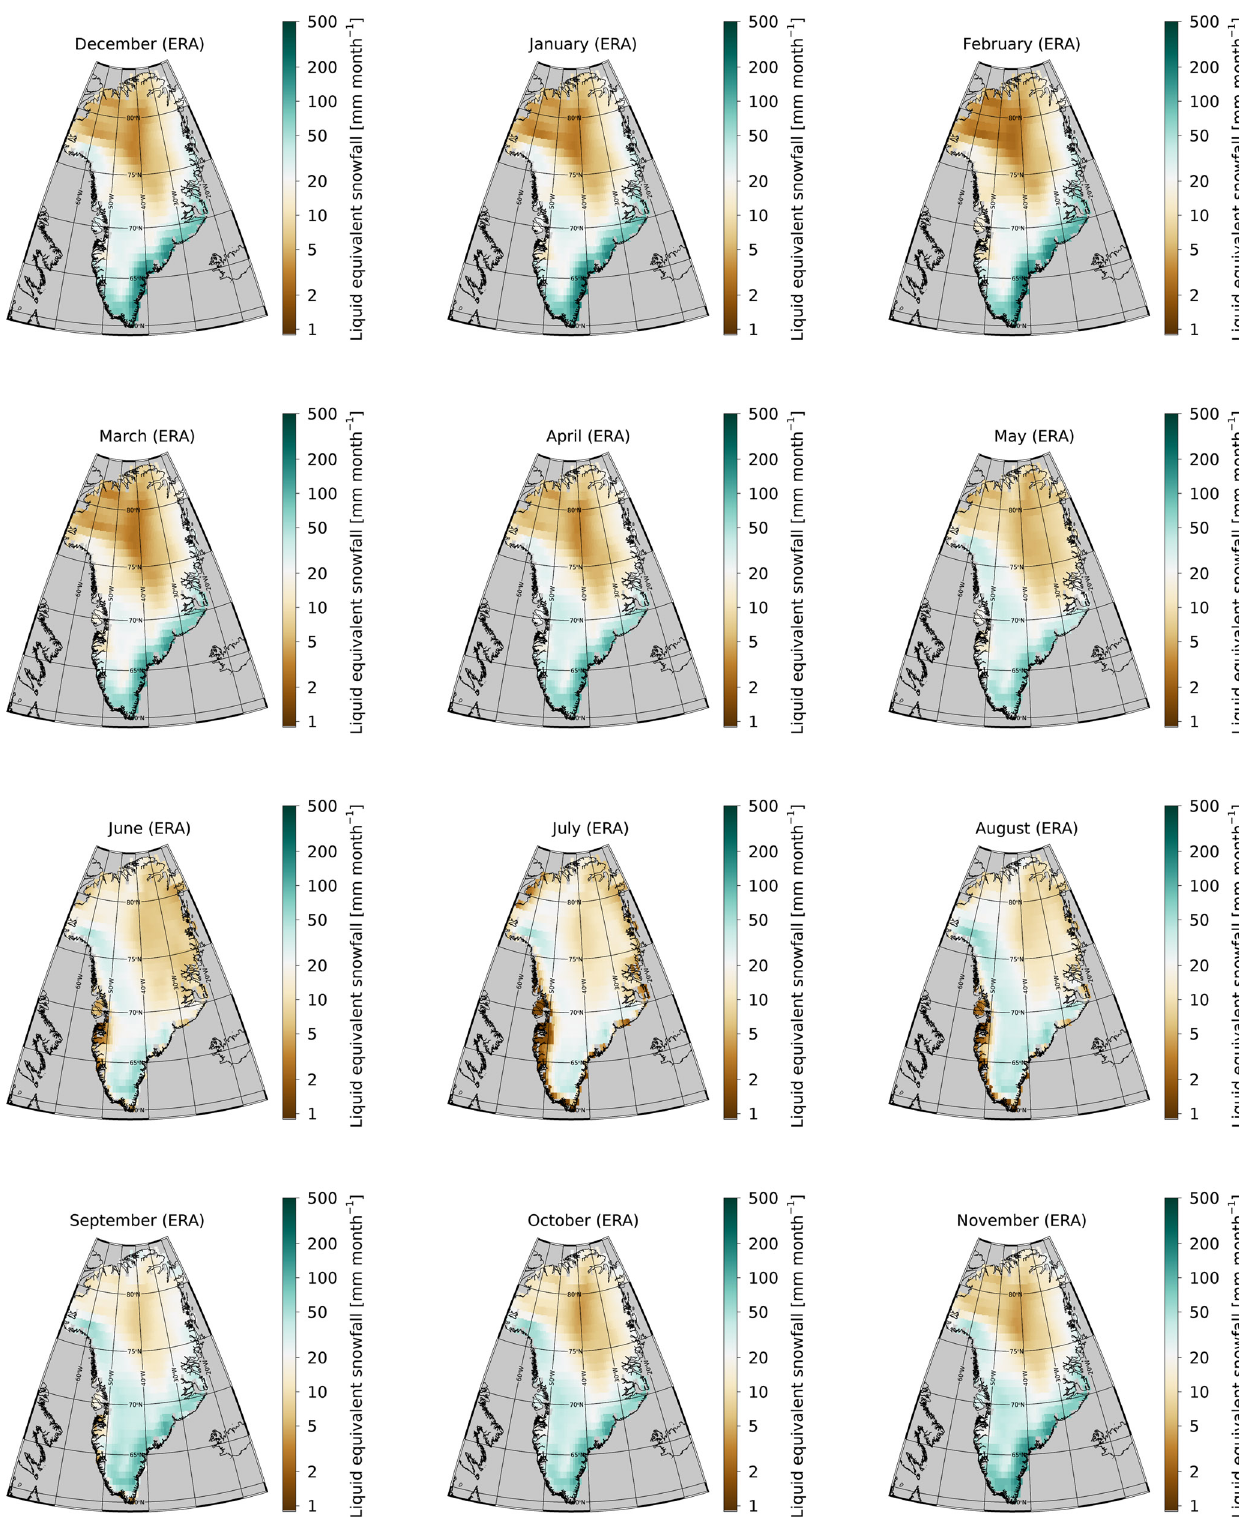
Figure 17. Same as Fig. 16 but for